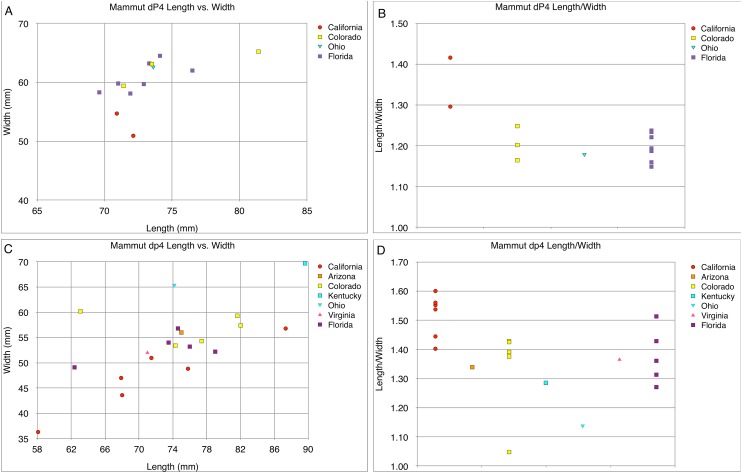
Length and width comparisons of Mammut dP4 and dp4, by state/province/country.(A) Length vs. width of Mammut dP4. M. pacificus is indicated in red, (B) length/width of Mammut dP4, organized by location. M. pacificus is indicated in red, (C) length vs. width of Mammut dp4. M. pacificus is indicated in red, and (D) length/width of Mammut dp4, organized by location. M. pacificus is indicated in red.